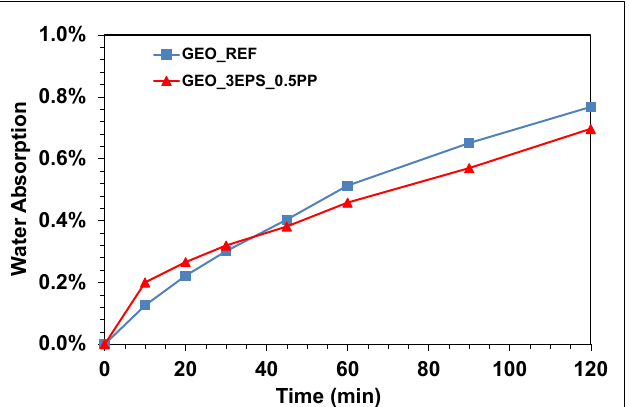
Figure 10. Water absorption (%) vs. time (min) for the reference and reinforced samples.